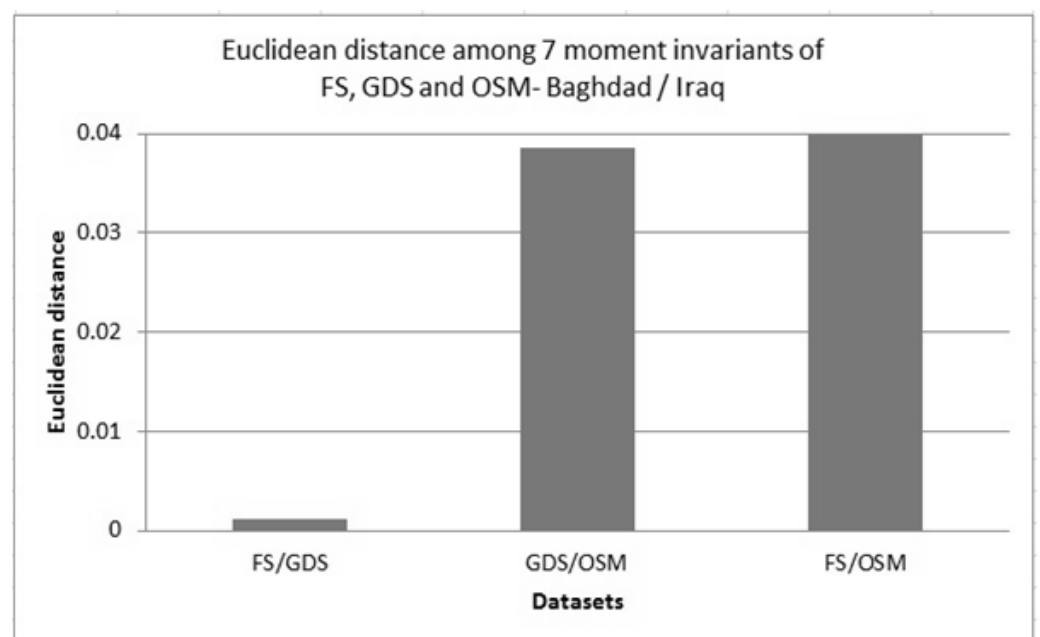
Figure 8. An example of the comparison of Euclidean distance of 7 moment invariants for three datasets (field survey (FS), General Directorate for Survey (GDS) and OSM) in Baghdad,